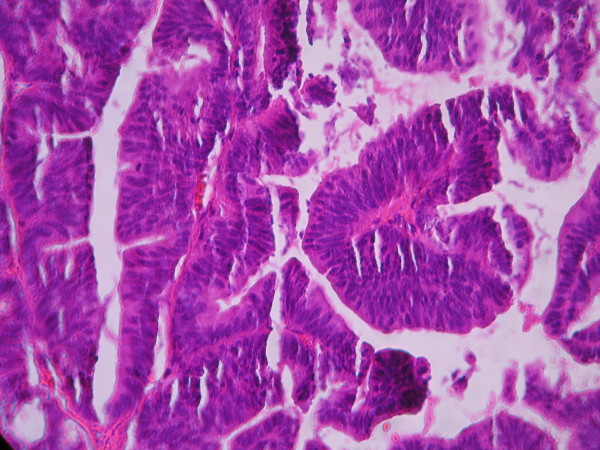
Endometrial adenocarcinoma. Papillary growth pattern of glands with stratified nuclei and mild nuclear atypia (High power)